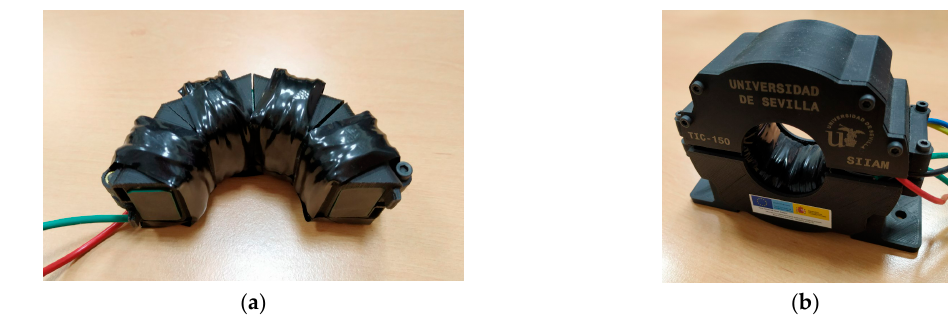
Figure 10. ( a ) Half ferrite core and its coils; and ( b ) whole protected